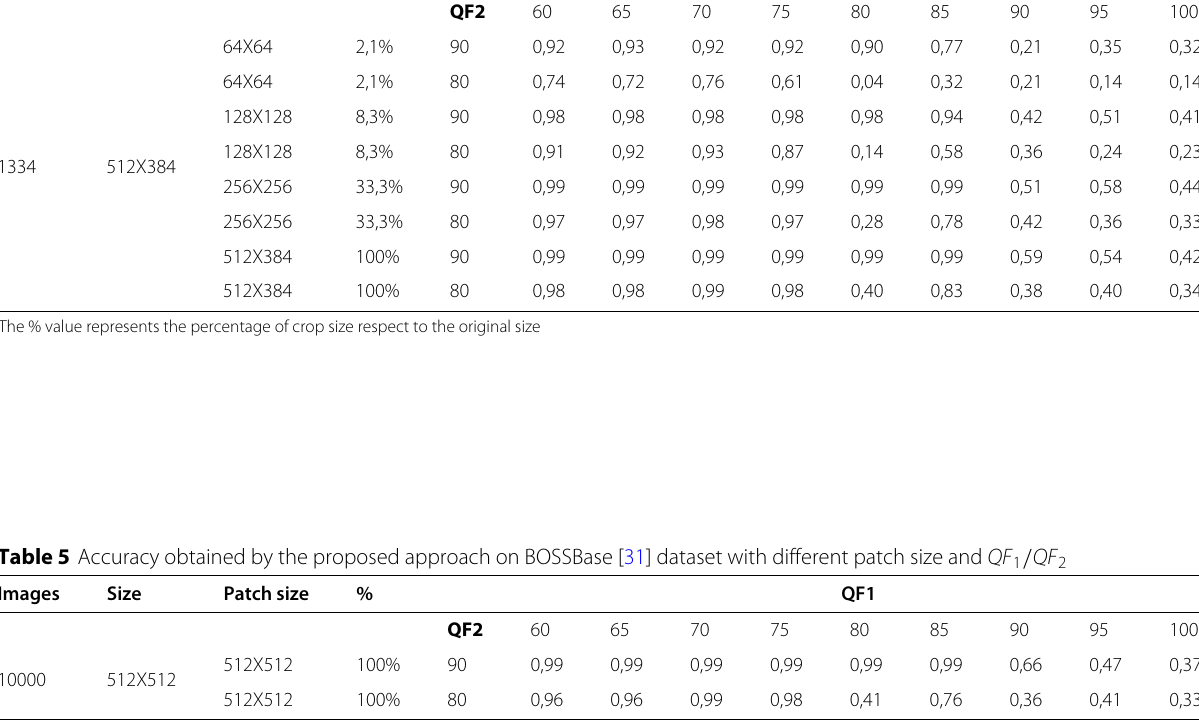
Table 4 Accuracy obtained by the proposed approach on UCID [34] dataset with different patch size and QF 1 / QF 2 Images Size